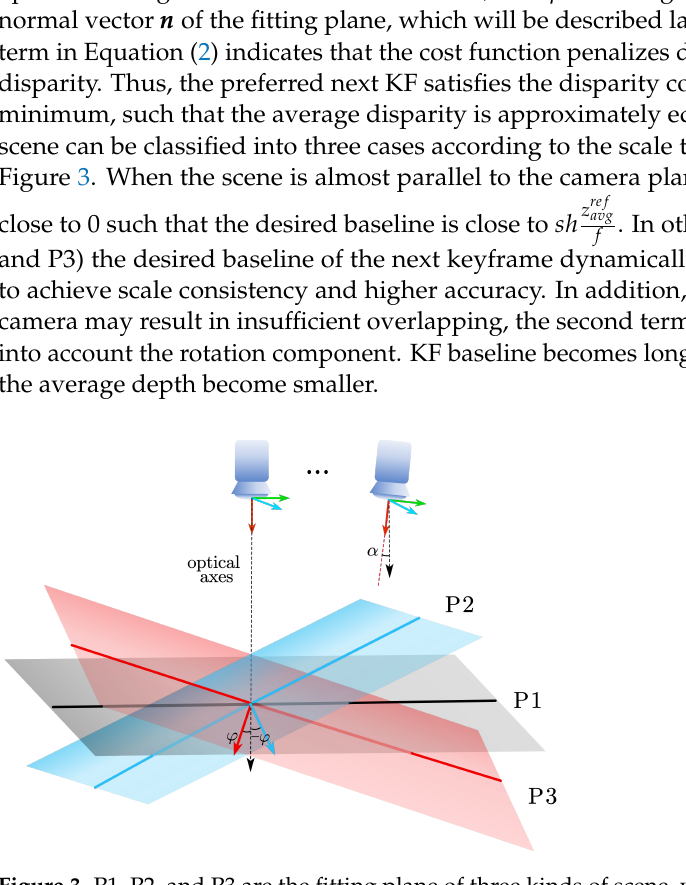
Figure 3. P1, P2, and P3 are the fitting plane of three kinds of scene, which indicates three cases of the scale, i.e., remains stable, getting smaller, and getting